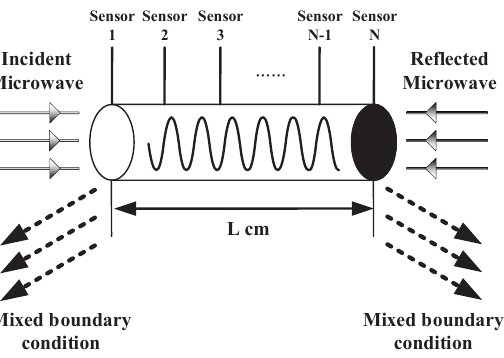
Figure 2. Detailed schematic for microwave heating